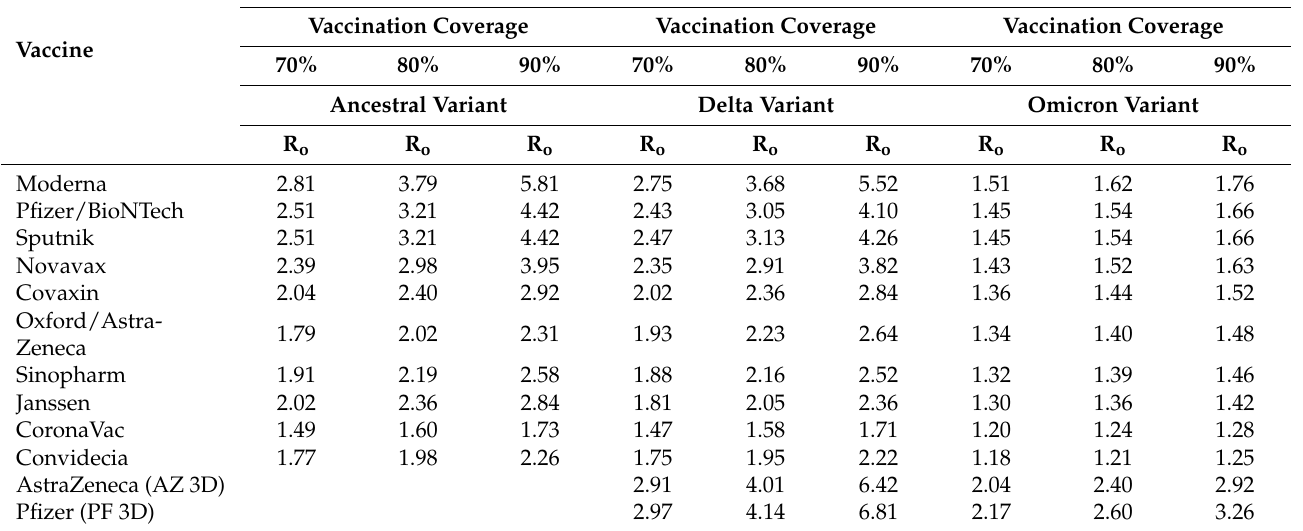
Table 6. R o of SARS-CoV-2 that COVID-19 vaccination programs could block by achieving 70%, 80%, and 90% vaccination coverage, without infections among vaccinated